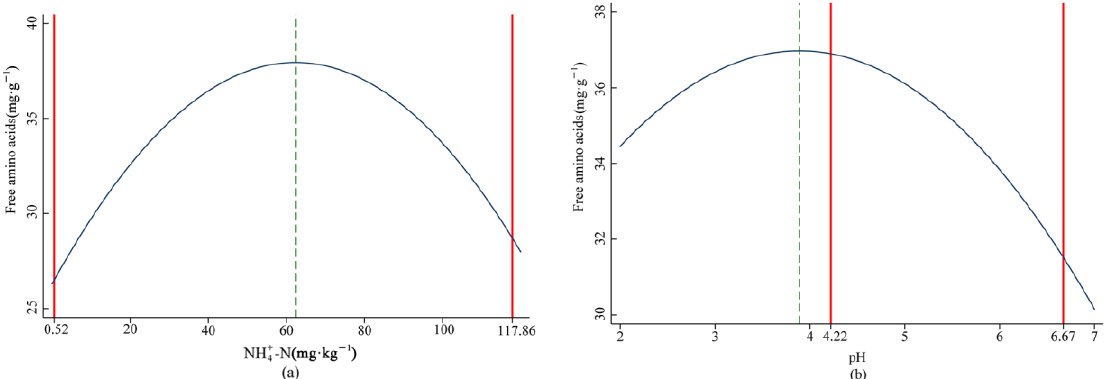
Figure 5. Quantitative relationship between the free amino acids and NH + -N and soil pH. ( a ) Quantitative relationship 4 between the free amino acids and NH + -N. ( b ) Quantitative relationship between free amino acids and soil pH. 4